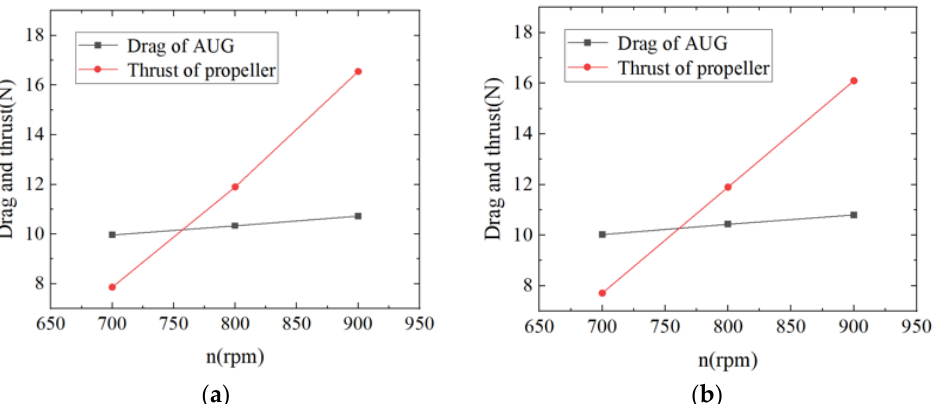
Figure 32. The self-propulsion simulation results of the hybrid-driven AUGs with different hull lines,